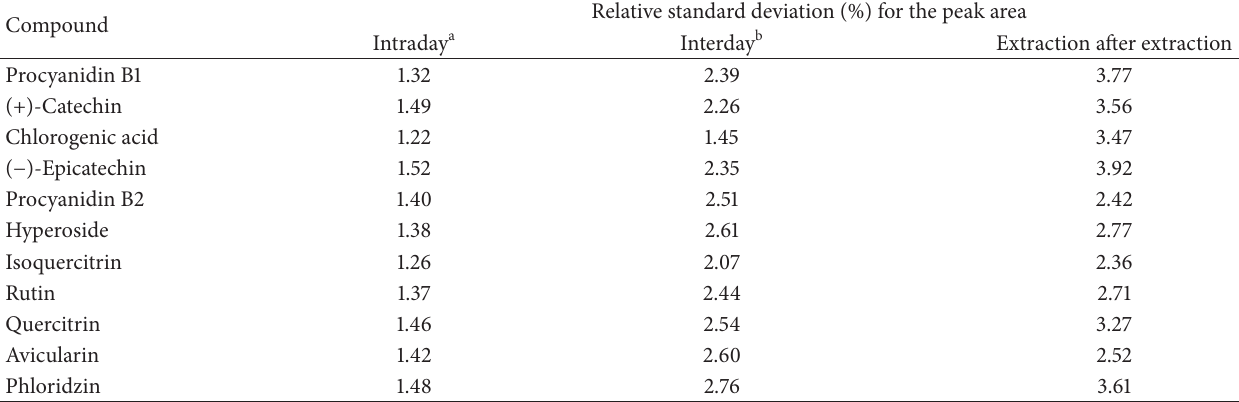
Table 2: Precision of the HPLC method for the quantitative evaluation of phenolic compounds.